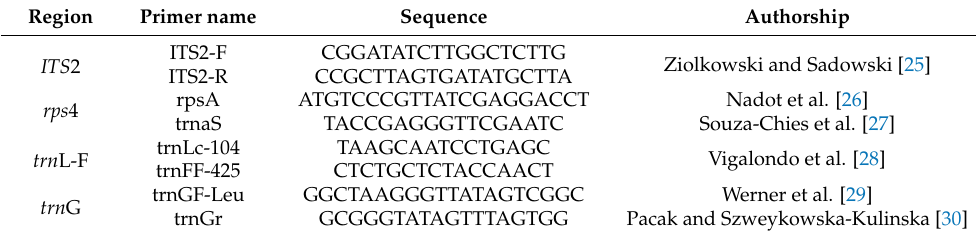
Table 4. Primers used for PCR amplification and sequencing.